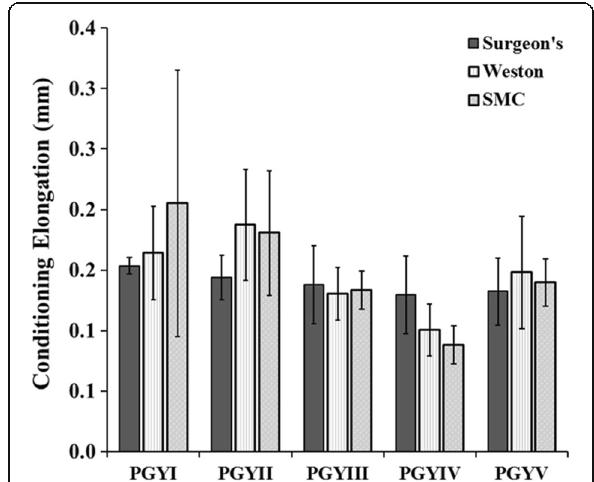
Fig. 2 Conditioning Elongation. Conditioning elongation as a function of resident training for the surgeon ’ s, Weston and SMC knots. Results